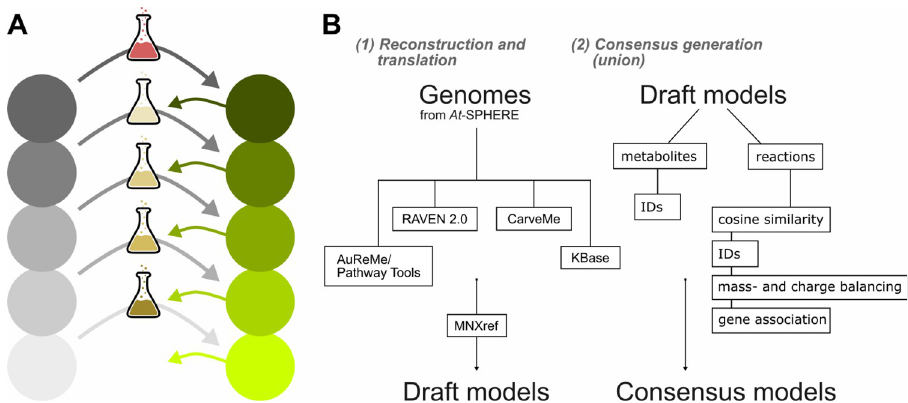
Fig 2. Schematic workflow of metabolic model reconstruction from multiple approaches. (A) The consensus models were gap-filled conditional on the community composition according to COMMIT. Grey circles represent the reconstructions for every organism before gap filling. Green color indicates functional models after gap filling. The medium for the first reconstruction was the respective auxotrophic medium predicted using KBase [13] (red medium). For subsequent reconstructions, a minimal medium was used, which was enriched by the secreted metabolites of already gap-filled models (green arrows). (B) Annotated genomes from At-SPHERE were used as the basis to reconstruct 432 draft metabolic reconstructions using the four recent methods from KBase [13], CarveMe [14], RAVEN 2.0 [17], and AuReMe/Pathway Tools [15,16].These draft reconstructions were merged into consensus reconstructions per